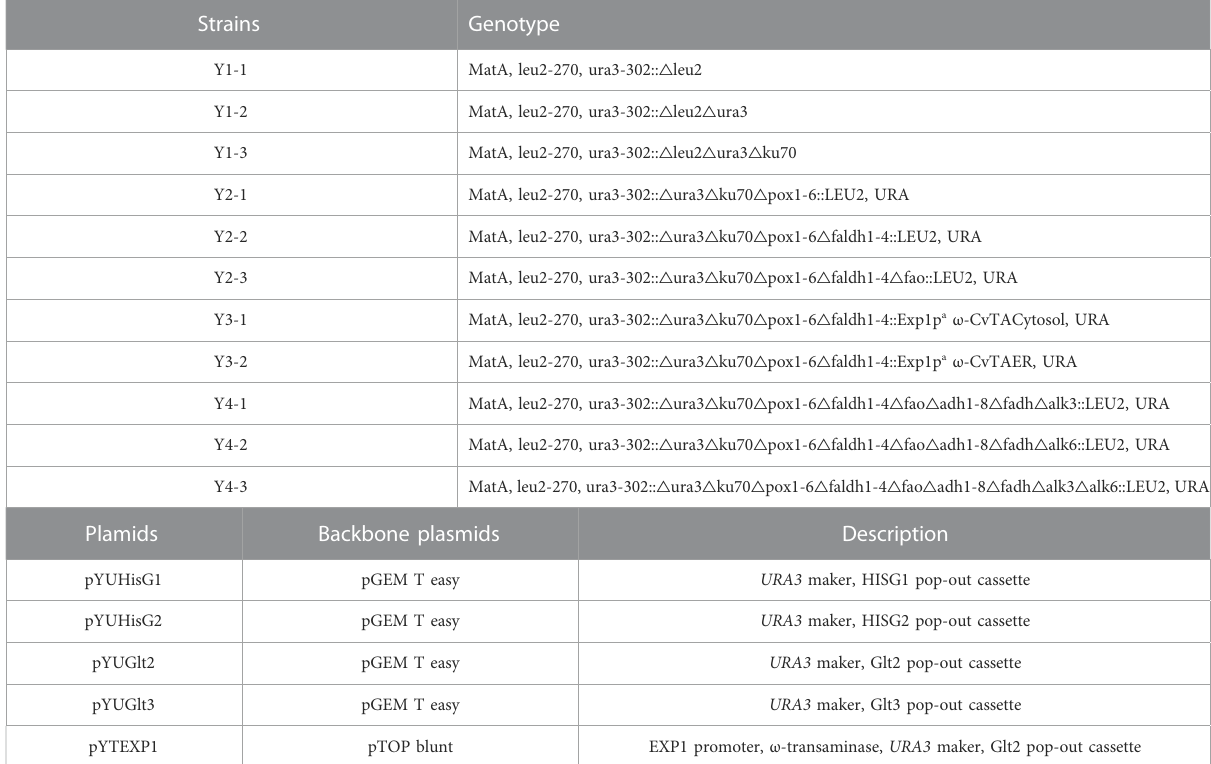
TABLE 1 Y. lipolytica strains and plasmids used in this study.